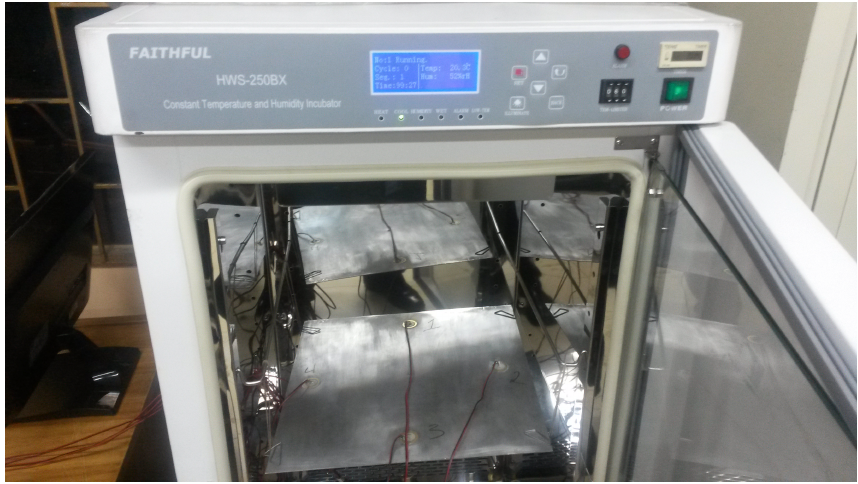
Figure 9. Aluminum plate inside the climate chamber (Faithful HWS-250BX).